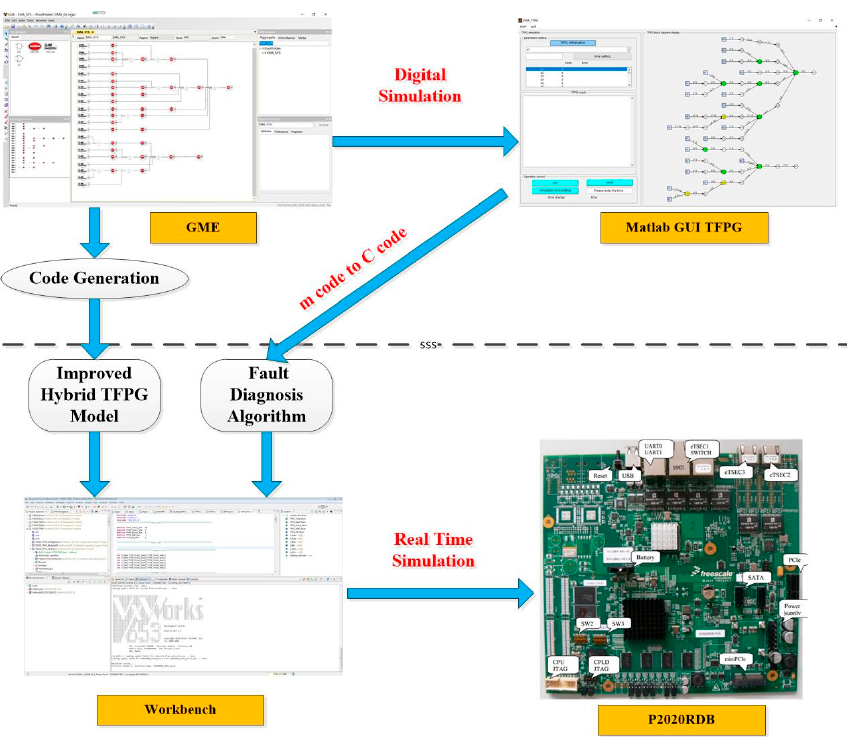
Figure 8. The systematic verification scheme.